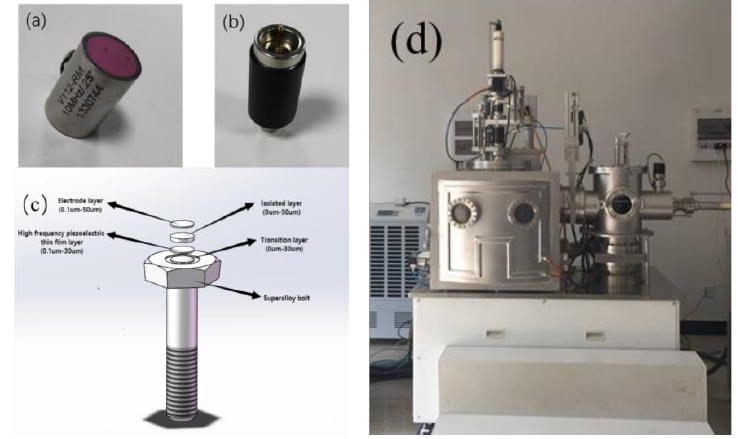
Figure 2. Photographs of ( a ) a commercial piezoelectric probe of 10 MHz and ( b ) a magnetically mounted transducer connector; ( c ) schematic diagram of a high-frequency M8 smart nickel-based superalloy bolt; ( d ) photograph of radio frequency magnetron sputtering.